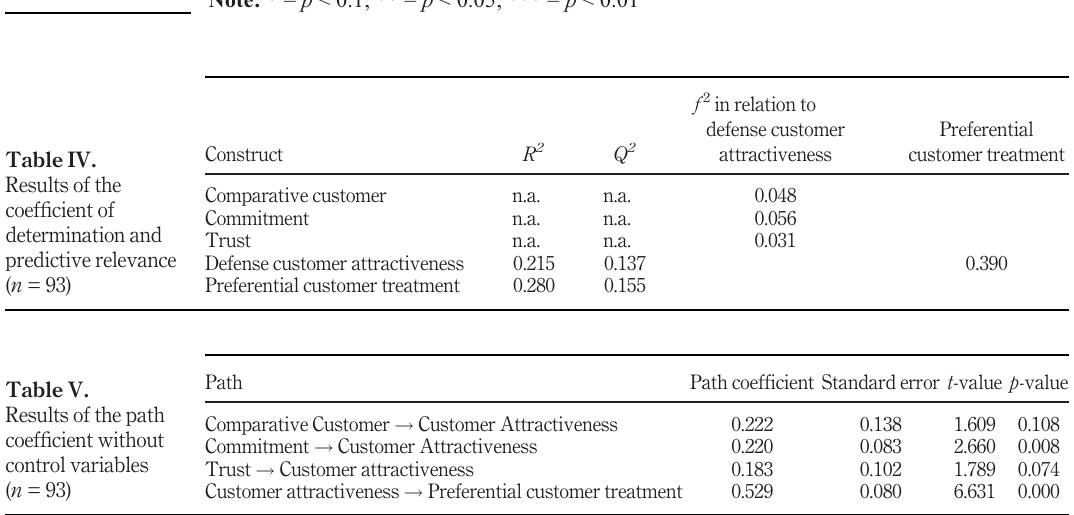
Figure 2. Results of the research model inclusive of the control variables